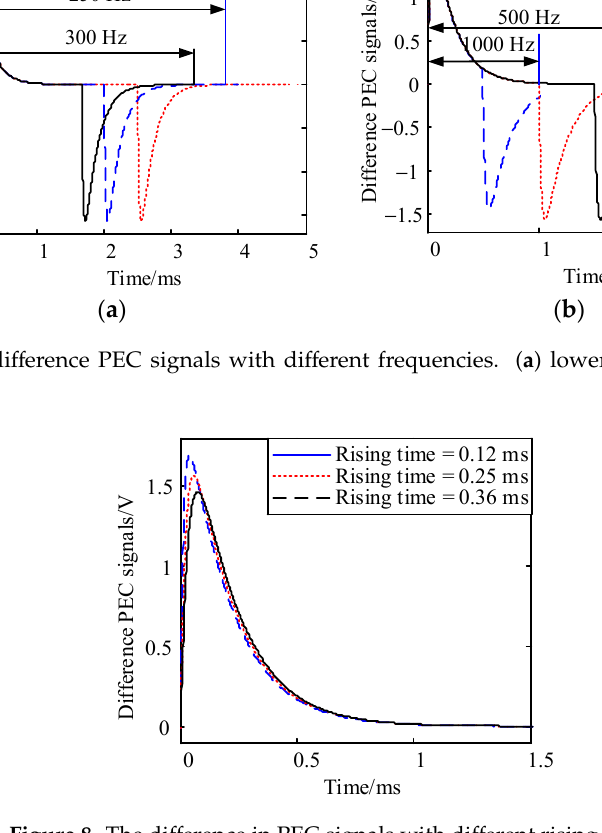
Figure 8. The di ff erence in PEC signals with di ff erent rising Figure 8. The difference in PEC signals with different rising times. Figure 8. The difference in PEC signals with different rising times.